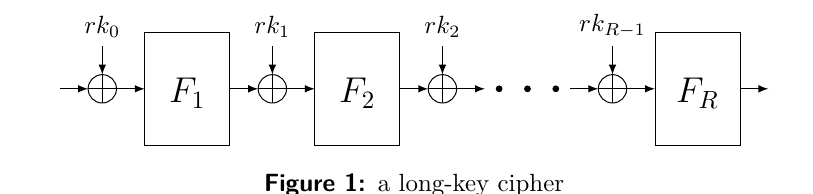
Figure 1: a long-key